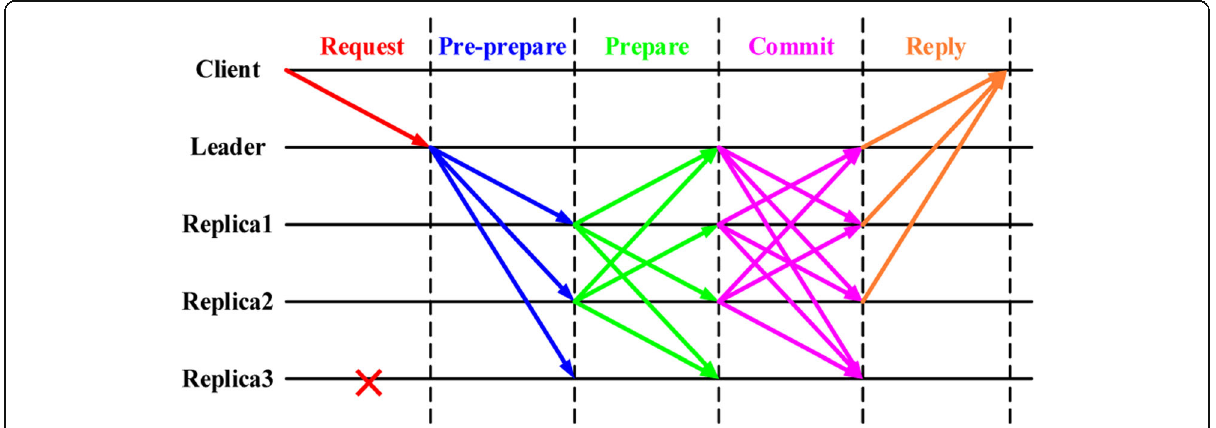
Fig. 7 Simplified PBFT algorithm consensus flow